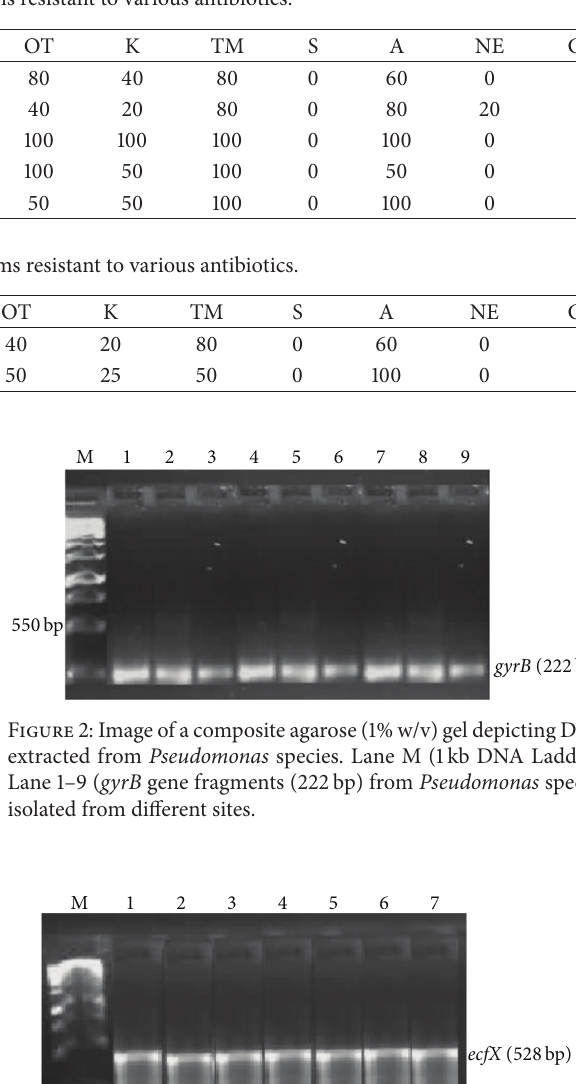
Table 5: Percentage of total coliforms resistant to various antibiotics.